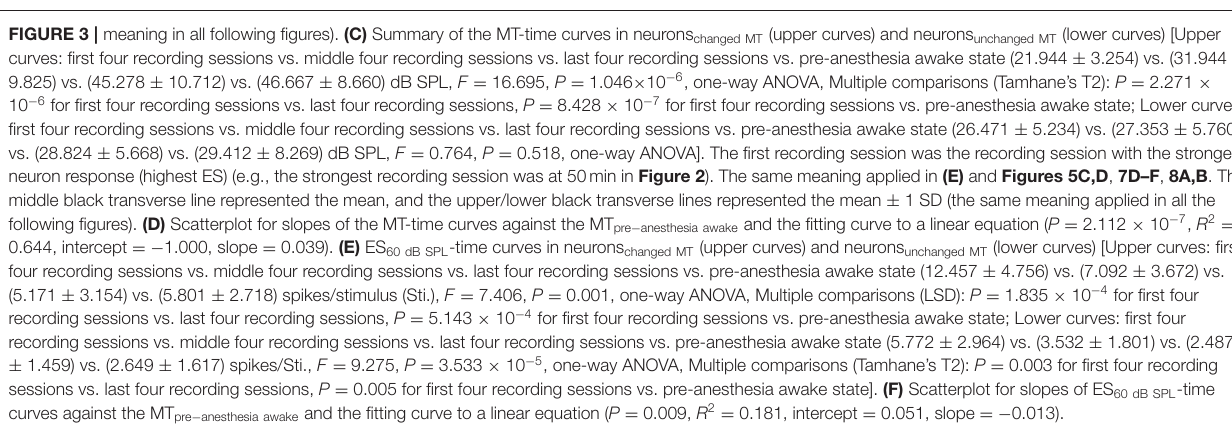
FIGURE 3 | meaning in all following figures). (C) Summary of the MT-time curves in neurons changed MT (upper curves) and neurons unchanged MT (lower curves) [Upper curves: first four recording sessions vs. middle four recording sessions vs. last four recording sessions vs. pre-anesthesia awake state (21.944 ± 3.254) vs. (31.944 ± 9.825) vs. (45.278 ± 10.712) vs. (46.667 ± 8.660) dB SPL, F = 16.695, P = 1.046 × 10 − 6 , one-way ANOVA, Multiple comparisons (Tamhane’s T2): P = 2.271 × 10 − 6 for first four recording sessions vs. last four recording sessions, P = 8.428 × 10 − 7 for first four recording sessions vs. pre-anesthesia awake state; Lower